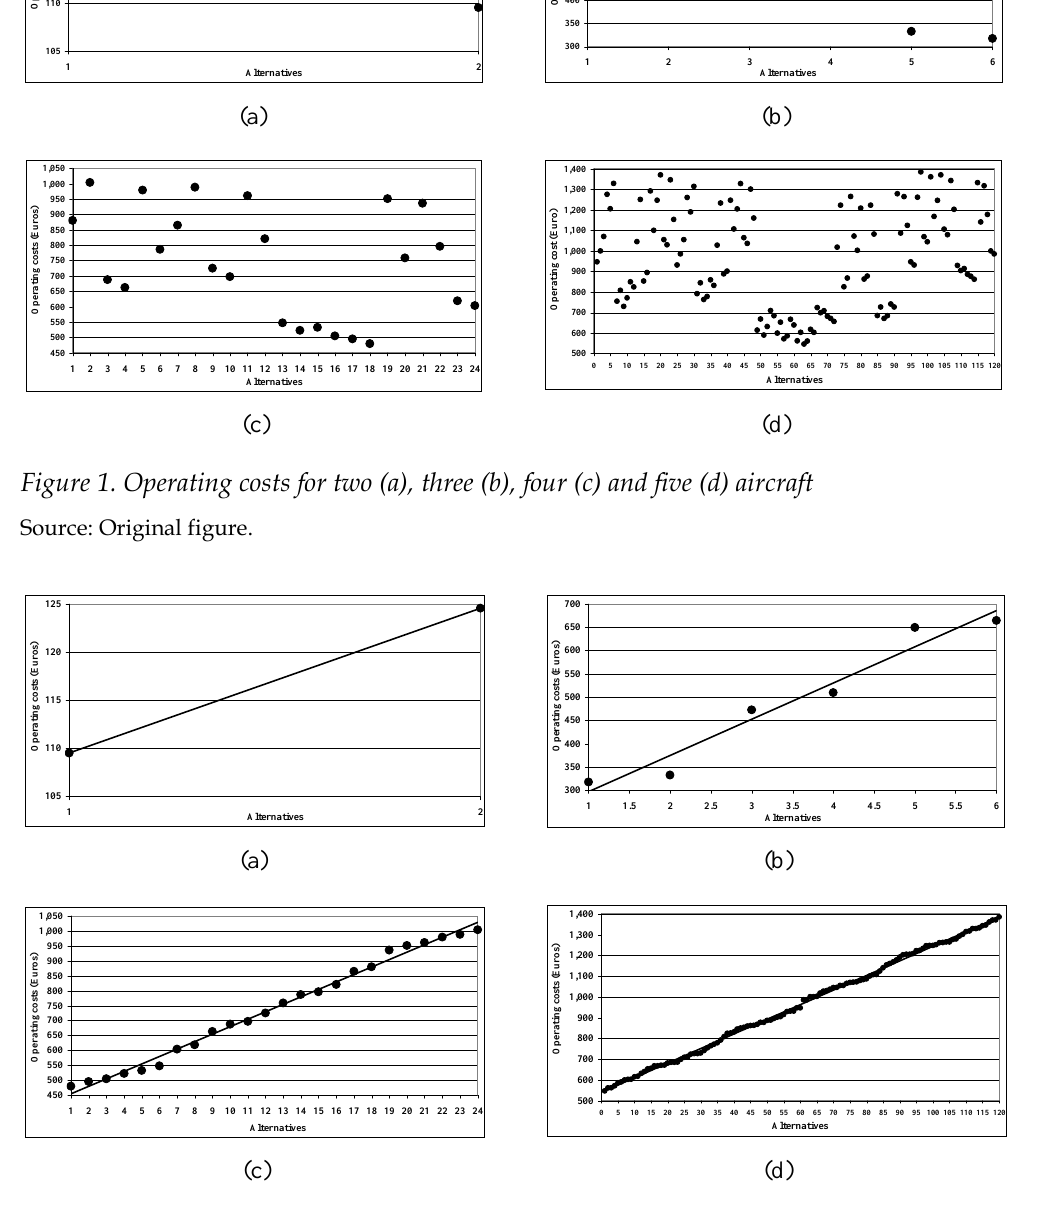
Figure 2. Operating costs arranged according to their values for two (a), three (b), four (c) and five (d) aircraft Source: Original